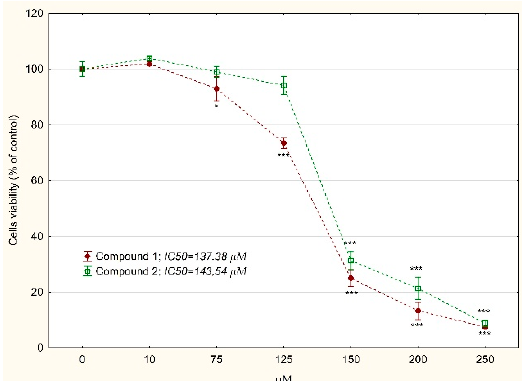
Figure 2. The relative MKN74 gastric cancer cells viability treated with compound 1 or 2 for 24 h determined by MTT assay. The results were calculated as % of control cultures’ viabilities which were averaged to define the 100%. Values were presented as mean ± SD derived from three independent experiments. * p < 0.05, *** p < 0.001 vs. control; (ANOVA followed by Tukey’s HSD post hoc analysis). IC 50 value was determined using the AAT Bioquest IC 50 calculator.